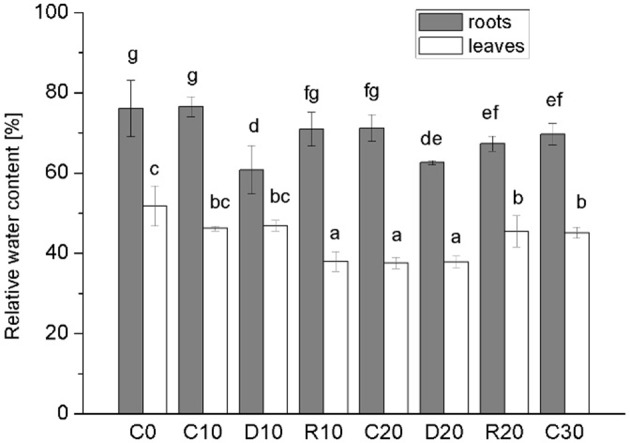
Relative water content. Separate columns for roots (dark) and leaves (white). Mean values (n = 3) are given. Vertical bars—standard deviations. C-control plants, C0, C10, C20, C30—the respective age controls (of days of treatment). D—plants subjected to water limitation treatment for 10 days (D10) or 20 days (D20). R—recovery by resuming optimal water supply for 10 days after 10 days (R10) or 20 days (R20) of water stress. Different letters above columns denote statistically significant differences.